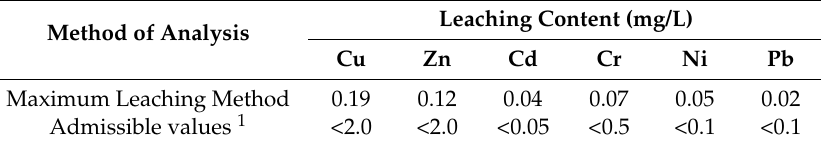
Table 4. Leaching of heavy metals from water extracts.